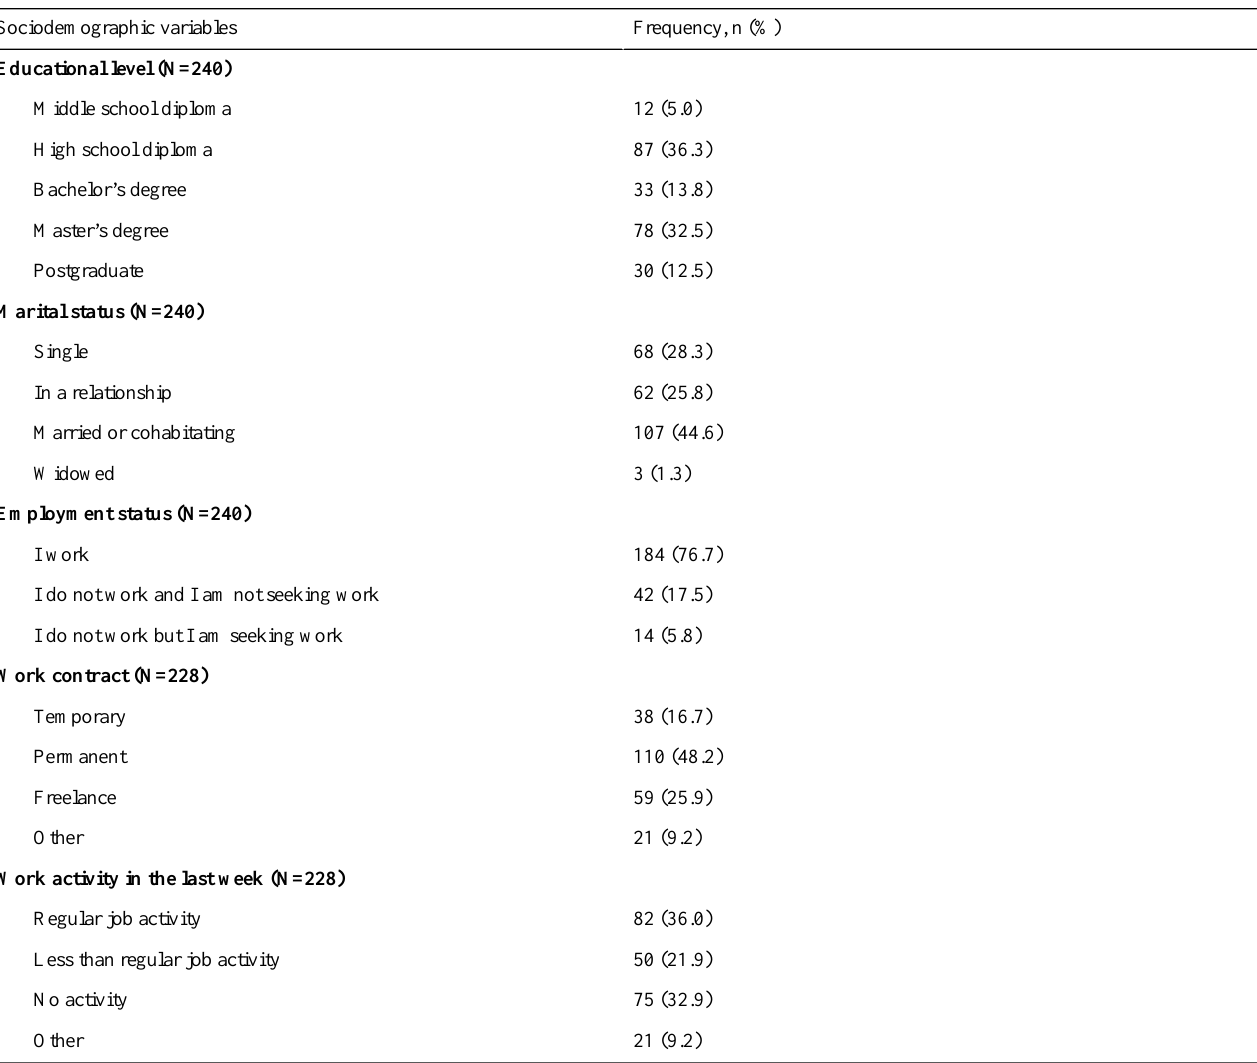
Table 1. Descriptive statistics of the sample.